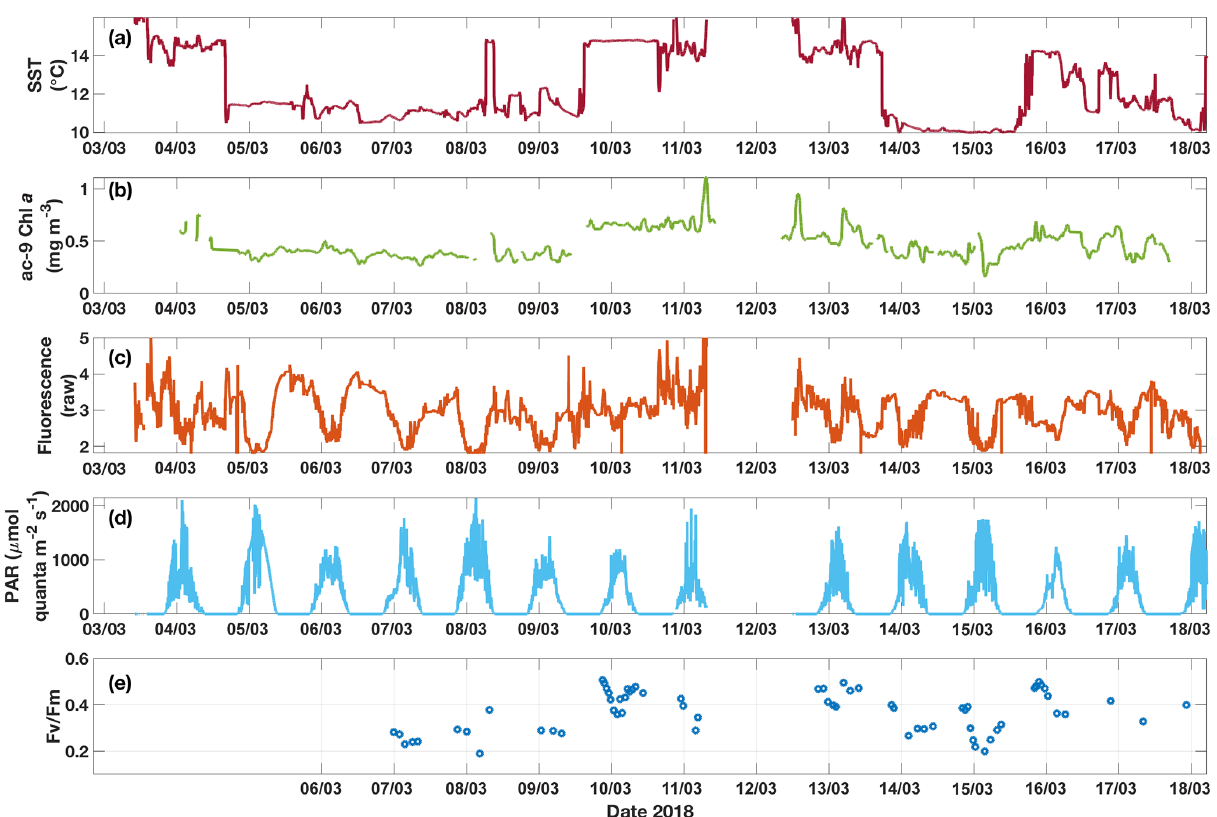
Figure 6. Time series for underway data from the SOTS voyage in 2018 of (a) SST, (b) Chl a from ac-9, (c) raw fluorescence, (d) above- water PAR and (e) F v /F m measured on dark-acclimated discrete samples. Diel fluctuations in fluorescence are apparent, especially when cold water was sampled. These fluctuations are not found in the corresponding Chl a time series. Note that the data gap around 12 March is due to the ship leaving the SAZ region during that